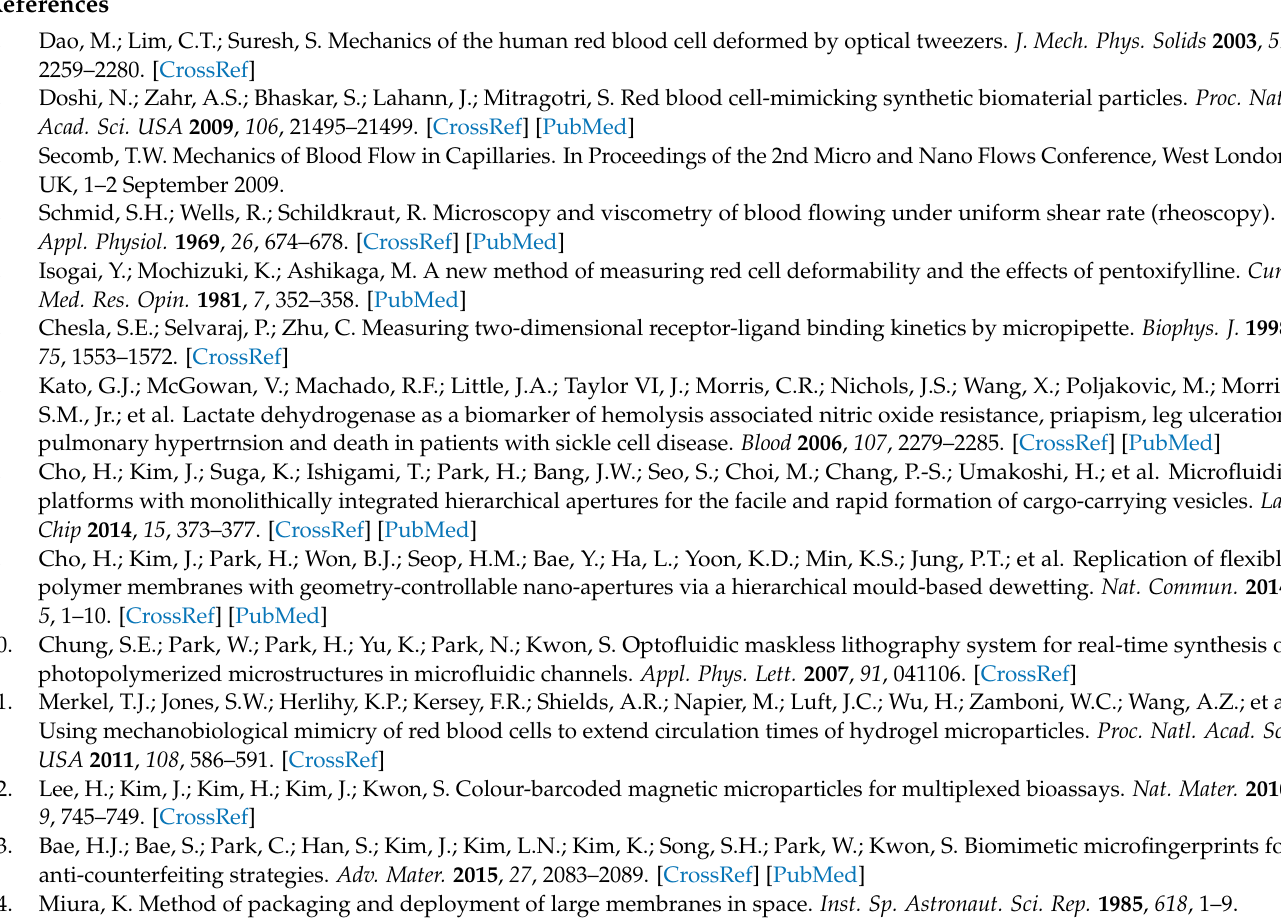
Deformation ratio at 100 hPa, (B) 200 hPa, (C) 300 hPa, (D) 400 hPa, (E) 500 hPa, (F) 600 hPa, (G) 700 hPa, (H) 800 ~ 1000 hPa. (Scale bar: 50 µ m). Figure S2.3. Deformation ratios of the horseshoe and spiral particles by increasing flow pressures, (A) Deformation of horseshoe particle at 100 ~ 200 hPa, (B) Deformation of spiral particle at 100 ~ 200 hPa. (Scale bar: 50 µ m). Figure S3: Recovery of the spiral particle shape after passing through the tapered channel at flow of 200 hPa (Scale bar: 50 µ m). Figure S4: Measurement of the diffusion area of the Rhodamine onto the agarose sheet. The area for the spiral particle is 112% larger than the area for the discotic particle, although the particles have the same effective volume index. ( V * = 0.5), as shown in Supplementary Table S2. Measurement of the red fluorescence intensity of the diffused Rhodamine-B on the agarose sheet. The spiral particle is 109% greater in intensity than the discotic particle, although the particles have same effective volume index. ( V * =